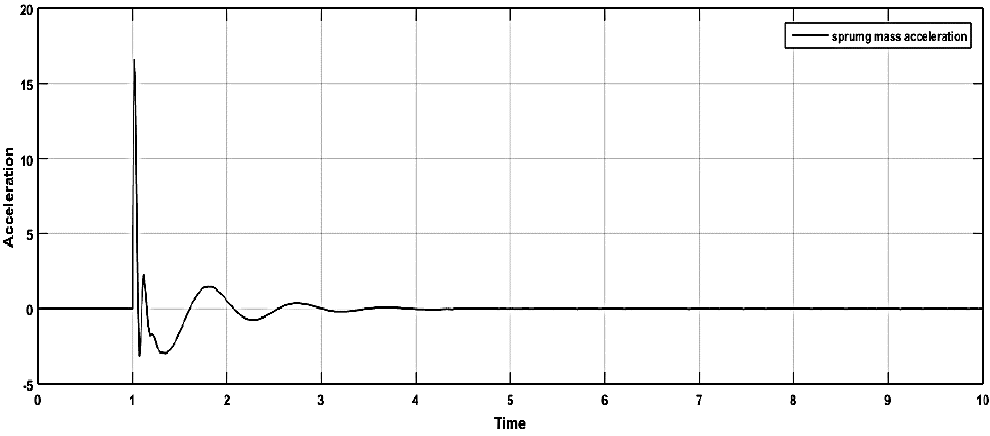
Figure 11. Acceleration of sprung mass Quarter car model